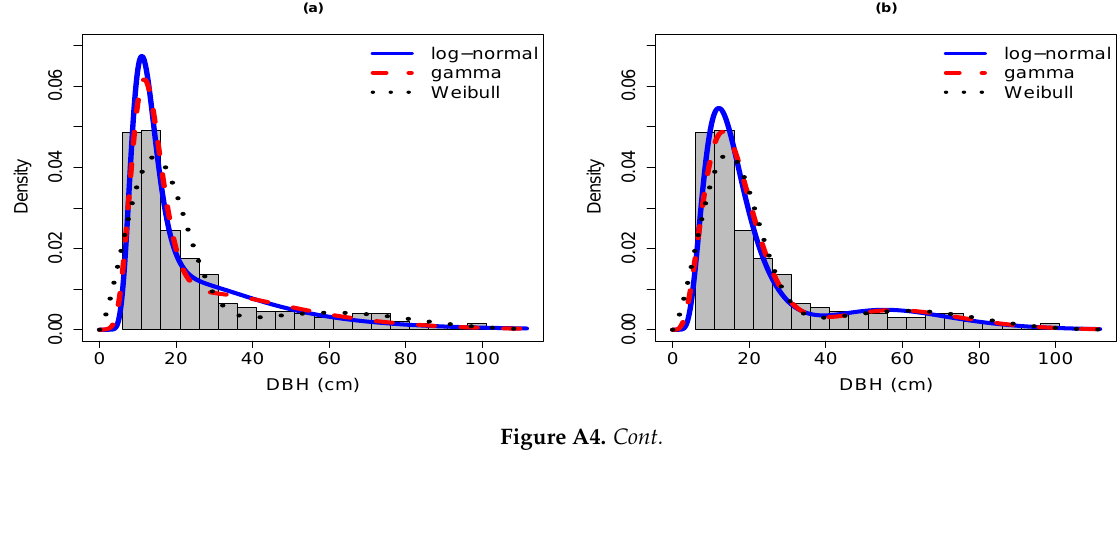
Figure A3. Histograms of DBH data in sample 3 corresponding to classes of width 2.5 cm. Superimposed in each subfigure are estimated pdf of the mixture of Weibull (solid line), gamma (dashed line), and log-normal (dotted line) distributions. The fitted pdf in subfigures are related to: ( a ) 2-component mixture models fitted to grouped data, ( b ) 2-component mixture models fitted to ungrouped data, ( c ) 3-component mixture models fitted to grouped data, ( d ) 3-component mixture models fitted to ungrouped data, ( e ) 4-component mixture models fitted to grouped data, and ( f ) 4-component mixture models fitted to ungrouped